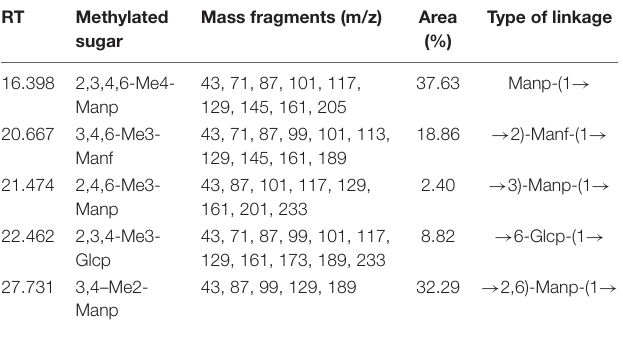
TABLE 2 | Type of linkage of S-EPS